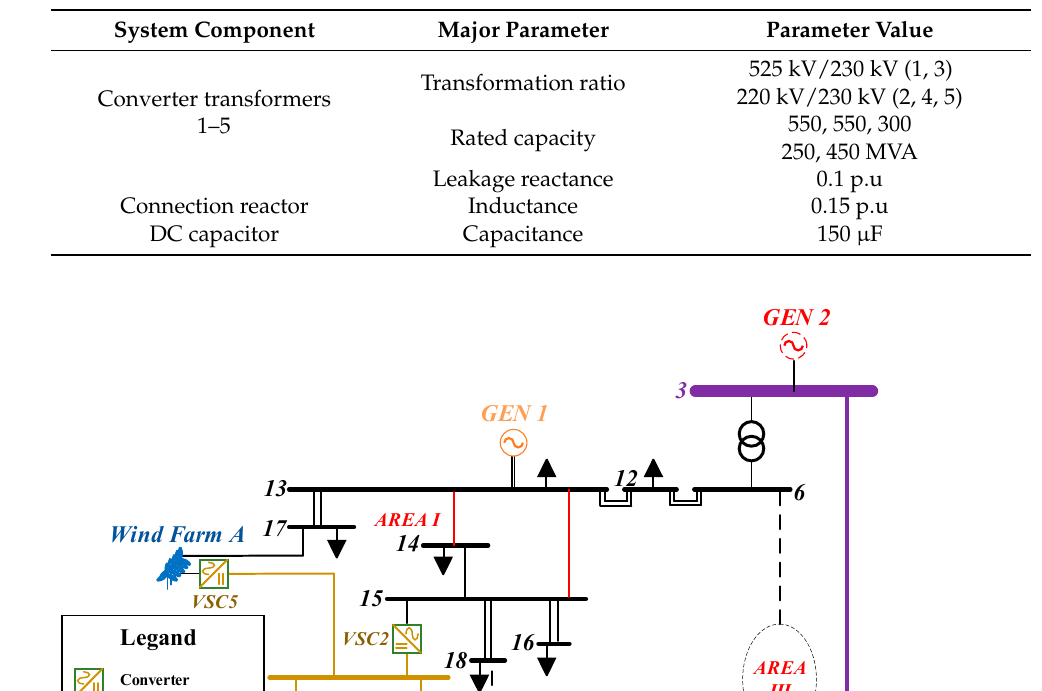
Table 4. Parameters of DC simulation model.